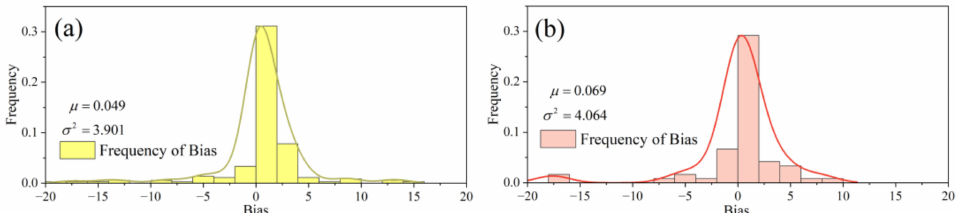
Figure 13. Statistical characteristics of the bias: ( a ) training data (from 2001 to 2015), ( b ) test data (from 2016 to